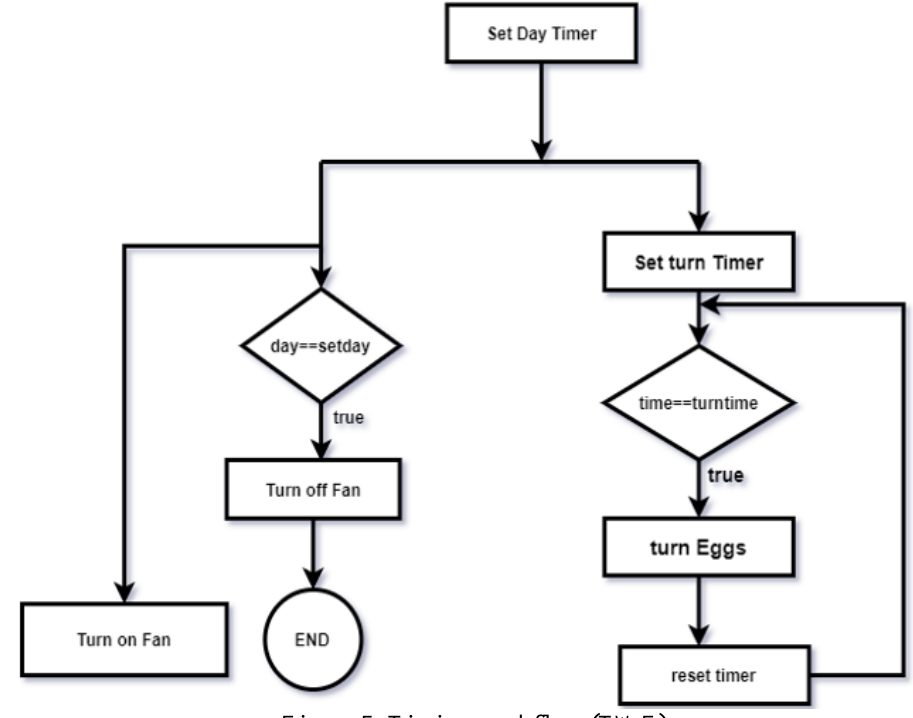
Figure 5. Timing workflow (TWF)